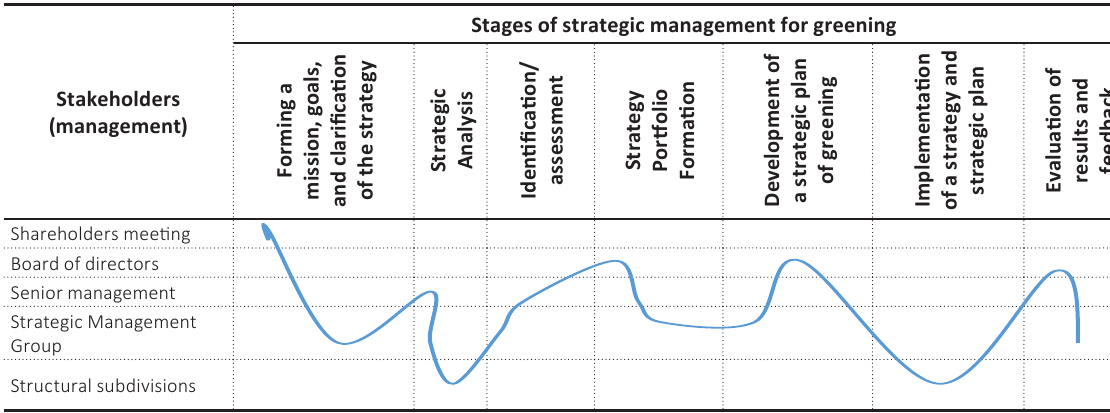
Figure 2. Optimal interactions between stakeholders and departments in the process of strategic management for